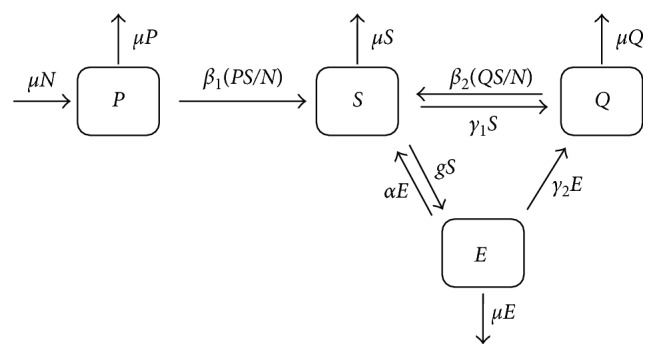
Schematic diagram of system (1).